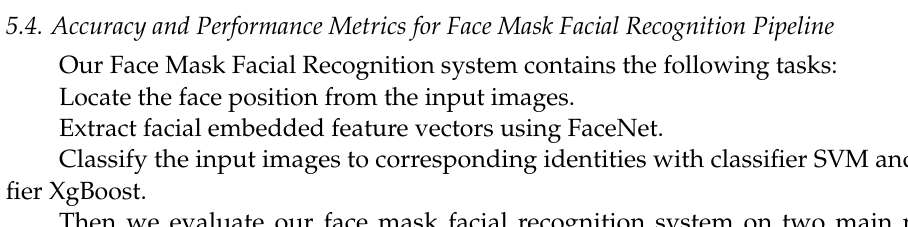
Figure 11. ( a )VGG16 Accuracy Curve, ( b ) VGG16 Loss Curve.